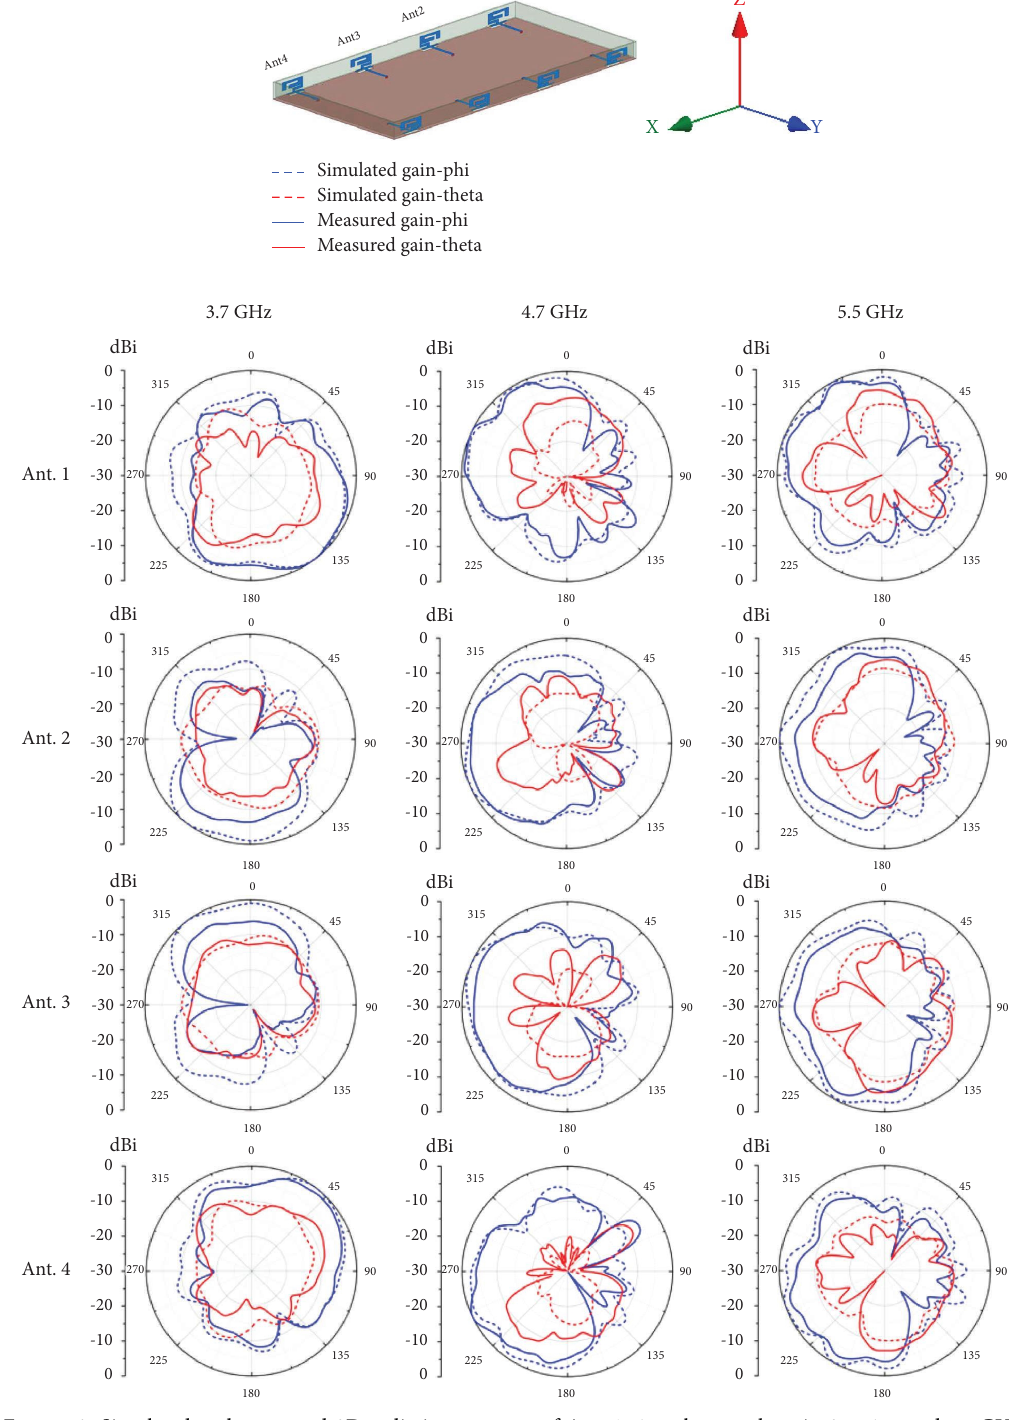
Figure 9: Simulated and measured 2D radiation patterns of Ant. 1–4 at the xy -plane in 3.7, 4.7, and 5.5